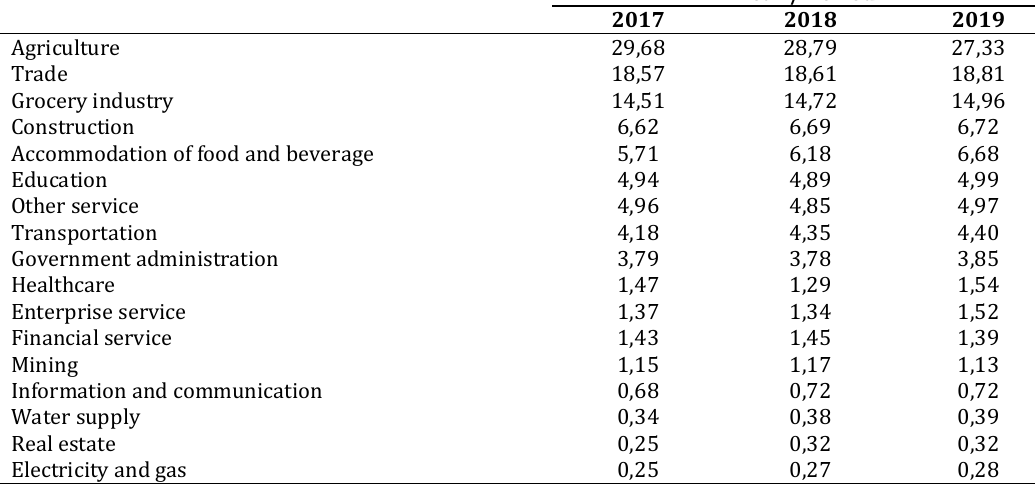
Table 1: The percentage of community based on their occupation